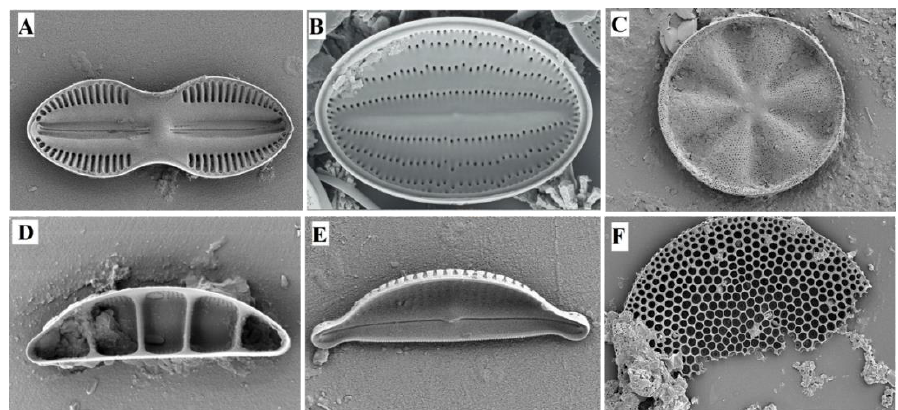
Figure 5. Scanning electron micrographs of the most common species in different stations: ( A ) Diploneis crabro , ( B ) Cocconeis placentula , ( C ) Actinoptychus sp., ( D ) Eunotogramma laevis, ( E ) Amphora sp., and ( F ) Coscinodiscus sp. Table 2. Pearson’s correlation coefficient (r and p value) of epipelic diatom abundance (cells/g) and di- versity (H’) against significant physicochemical variables at Port Dickson coast. Asterisk (*) indicates significance at 0.05 level (2-tailed). Parameters with no significant correlations were excluded. Physicochemical Abundances of Epipelic Diatom Variables Communities (cells/g)